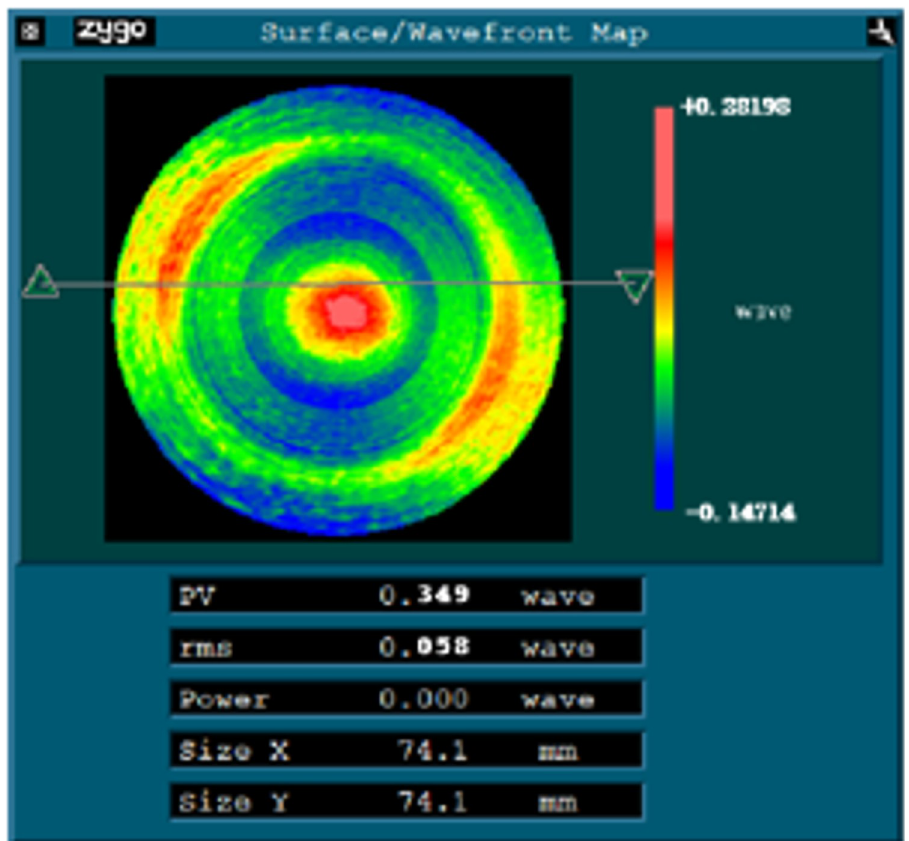
Fig 12. The result of the first compensation